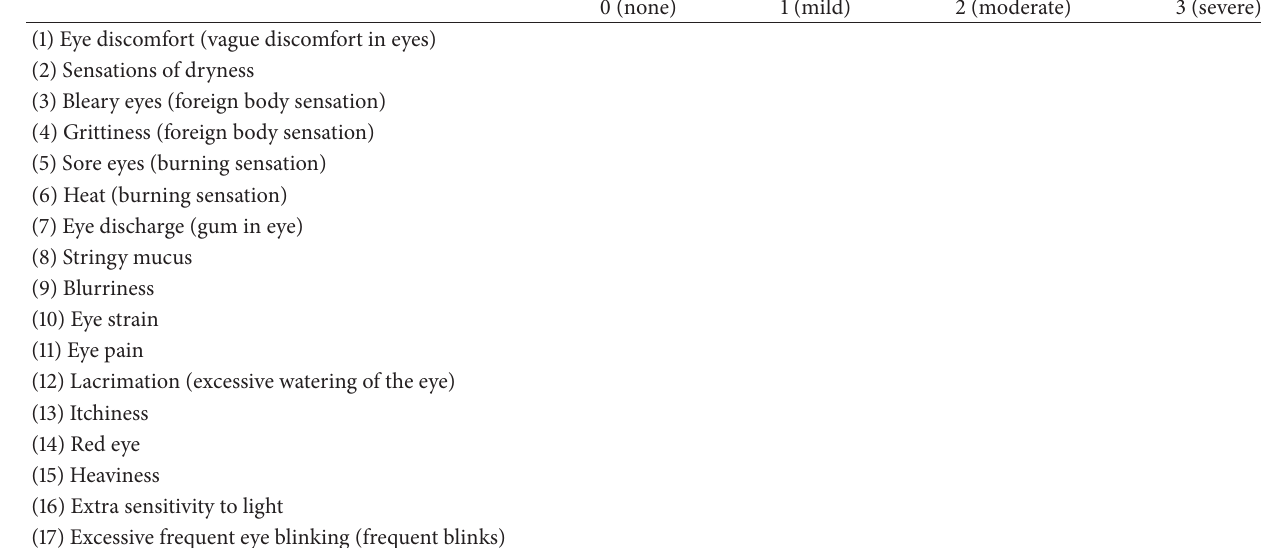
Table 6: Results of ocular symptoms questionnaire before and after 8 weeks of the study intervention.